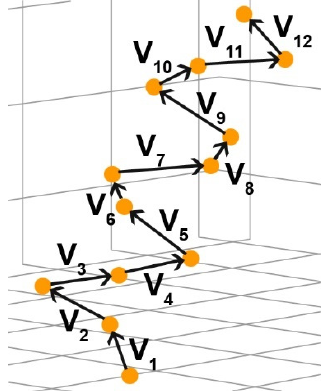
Figure 4. Graphical representation of vectors between neighboring C α atoms in a helical protein used for calculating a scalar triple product.